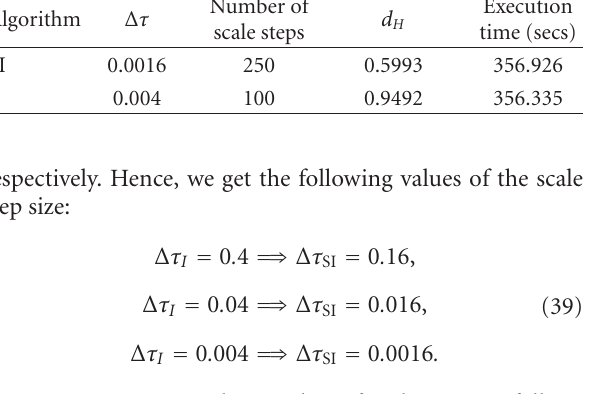
Table 3: Comparisons between two algorithms: E d = O (10 − 3 ).